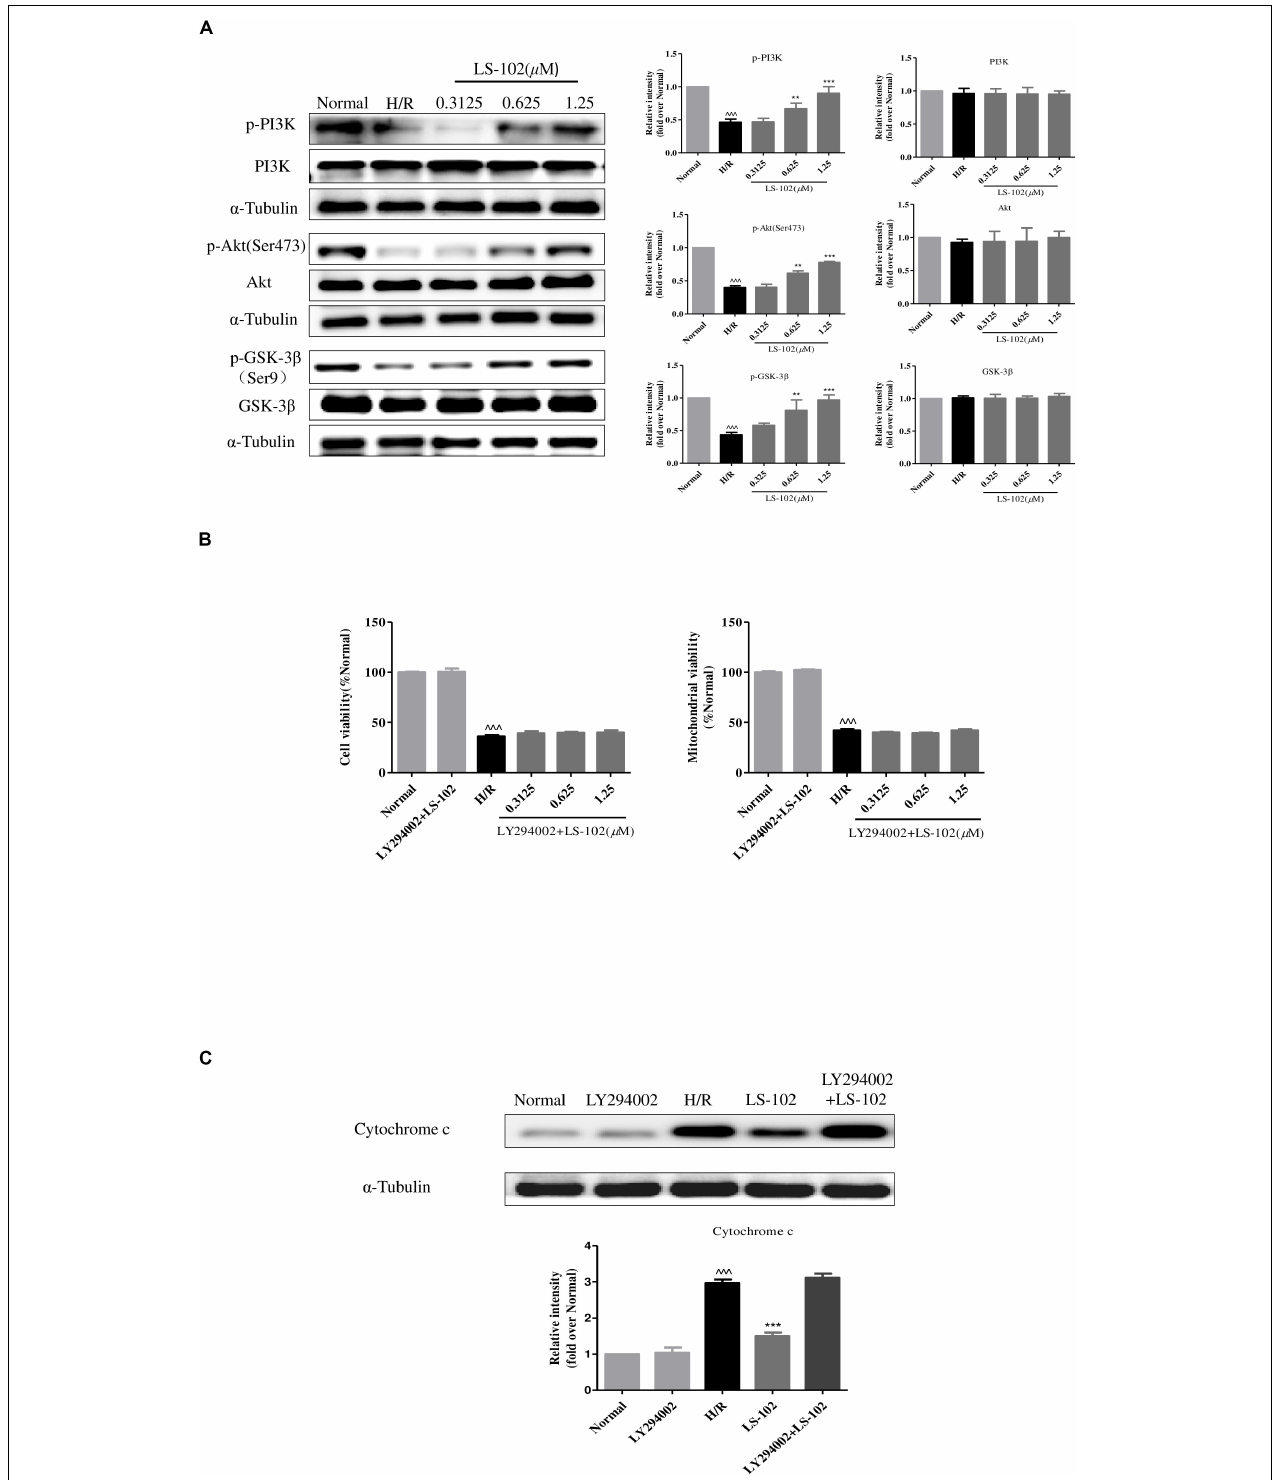
FIGURE 7 | Effect of LS-102 on PI3K/Akt/GSK-3 β pathway of H9c2 cells exposed to H/R. (A) The protein expression of PI3K, p-PI3K, Akt, p-Akt, GSK-3 β , and p-GSK-3 β was analyzed by Western blot. (B,C) PI3K inhibitor LY294002 (10 µ M) altered the effect of LS-102 on cell viability, mitochondrial viability, and the cytochrome c release after H/R in H9c2 cells. Values were the means ± SEM of three independent experiments in H9c2 cells after H/R. ˆˆˆ P < 0.001 vs. Normal group. ** P < 0.01 and *** P < 0.001 vs. H/R group.